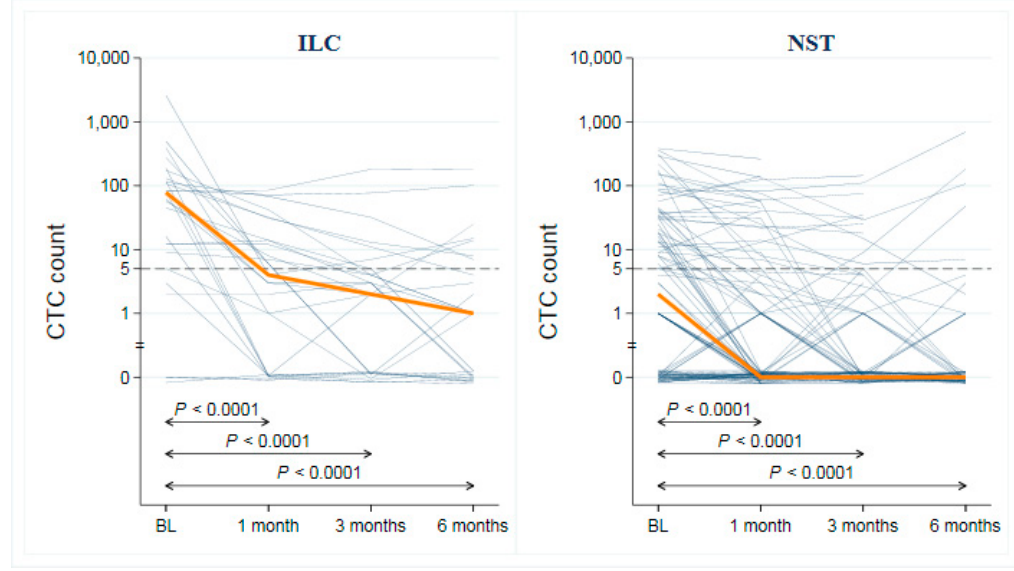
Figure 2. Circulating tumor cell (CTC) count at baseline by histopathological type. Abbreviations: ILC , invasive lobular carcinoma; NST , invasive ductal carcinoma of no special type; CTC count, number of CTCs per 7.5 mL blood.